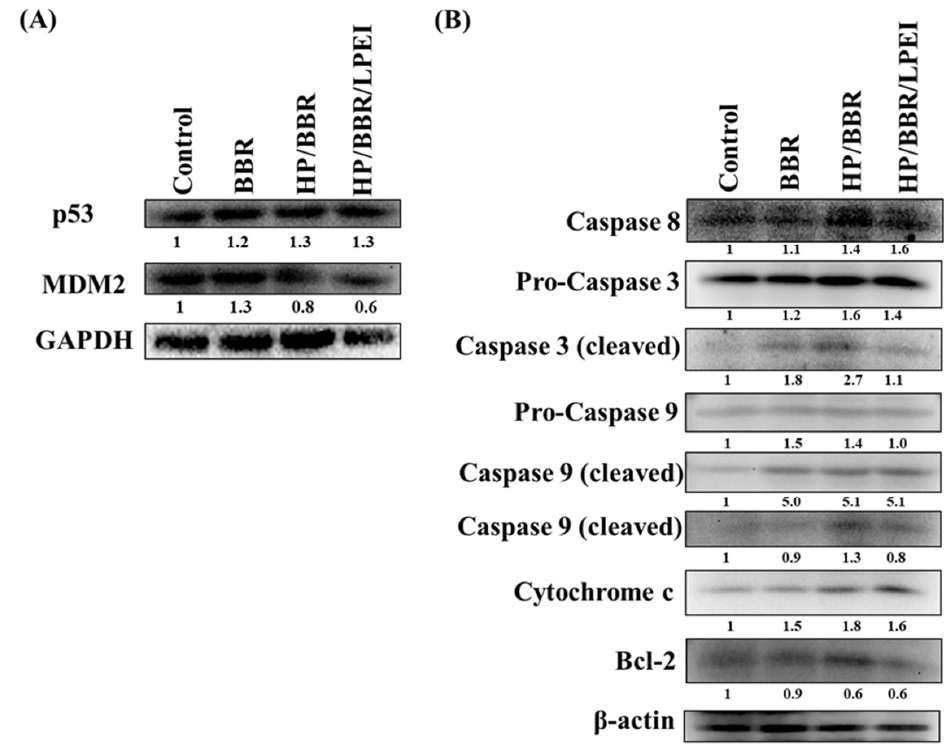
Figure 7. BBR affects the level of p53 and apoptosis-associated proteins in U-2 OS cells. ( A ). Cells were treated with BBR, HP/BBR NPs, and HP/BBR/LPEI NPs containing 50 µ M BBR for 48 h. Cells were collected and total proteins were analyzed by Western blotting. The levels of p53 and mouse double minute 2 homolog (MDM2) ( A ) and expressions of apoptosis-associated proteins including caspase 8, caspase 3, caspase 9, cytochrome c, and Bcl-2 ( B ) were determined by Western blotting as described in Materials and Methods.